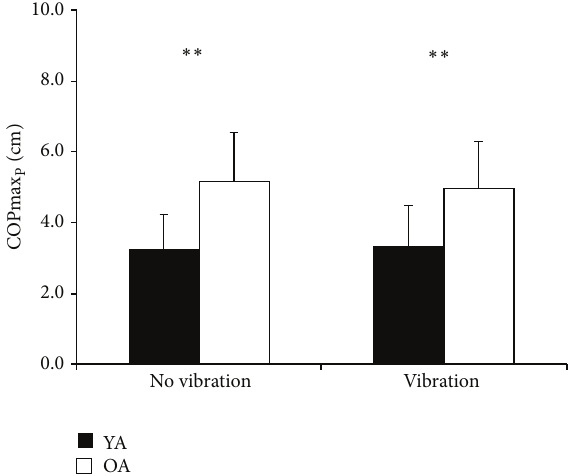
Figure 3: COPmax P means and SD of younger age group (YA) and older age group (OA) without vibration and with vibration. ∗∗ = 𝑝 < 0.01 .